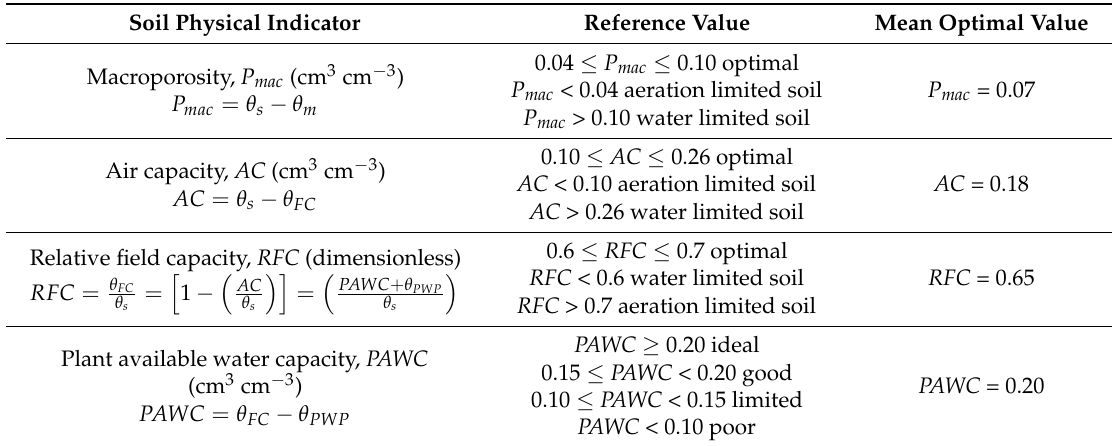
Table 1. Selected capacity-based indicators and corresponding optimal ranges or critical limits according to Reynolds et al. [62] and Castellini et al.